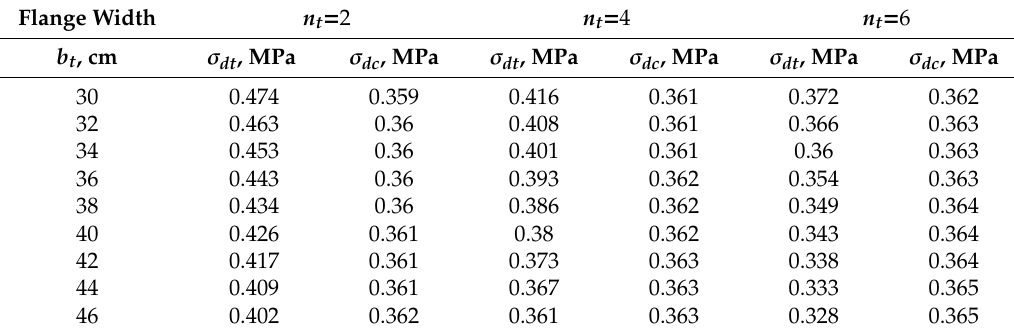
Figure 7. Dependences of dynamic normal stresses on the width of the I-beam flange b t and the number of reinforcement rods in the tension zone of a fiber-reinforced concrete beam taking into account the beam mass and bimodularity at n c = 2, E c = 2250 MPa, E t = 5000 MPa: ( 1 ) dynamic tensile stresses at n t = 2; ( 2 ) dynamic compressive stress at n t = 2; ( 3 ) dynamic tensile stresses at n t = 4; ( 4 ) dynamic compressive stress at n t = 4; ( 5 ) dynamic tensile stresses at n t = 6; ( 6 ) dynamic compressive stresses at n t = 6. Table 6. Dependences of dynamic normal stresses on the width of the I-beam flange b t and the number of reinforcement bars in the tension zone of a fiber-reinforced concrete beam, taking into account the beam mass and bimodularity at n c =